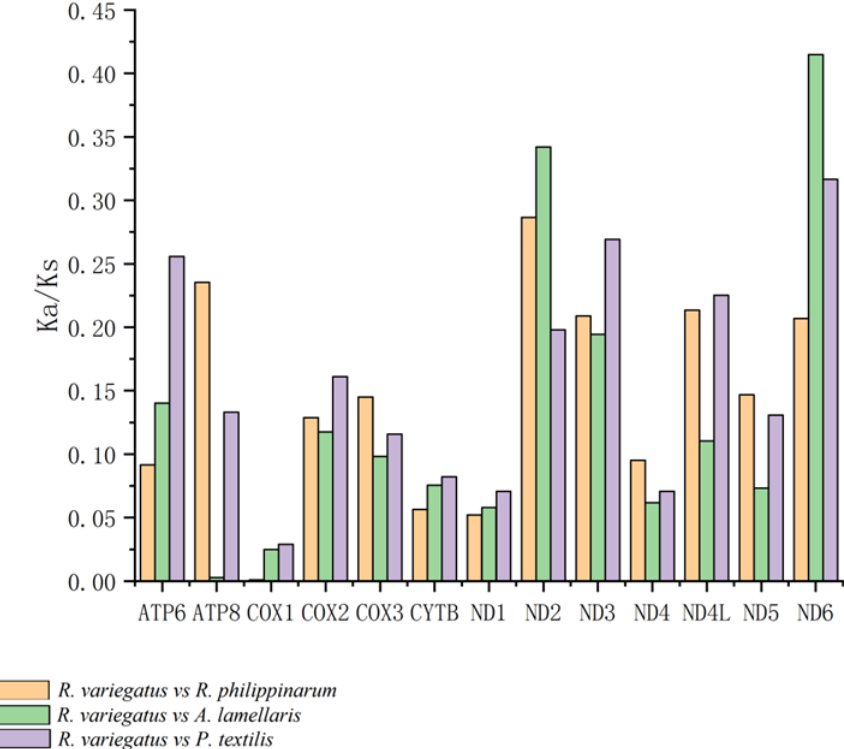
Figure 10. Values of the Ka/Ks ratio in 13 protein-coding genes of Ruditapes variegatus in relation to those of R. philippinarum , Antigona lamellaris , and Paratapes textilis.